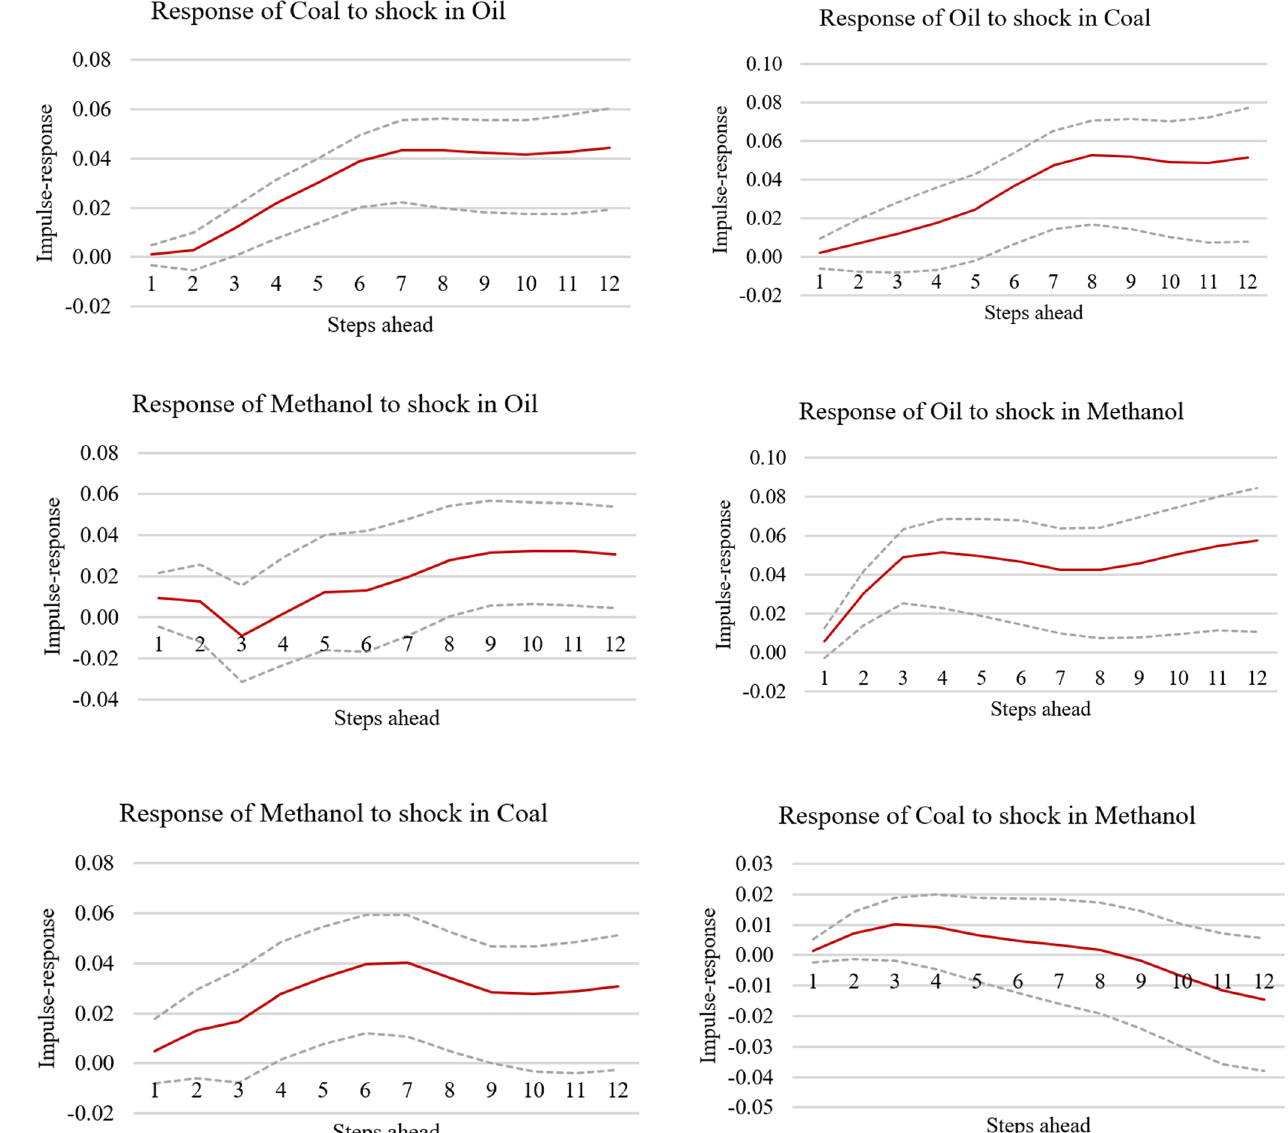
Figure 4. Generalized impulse-response functions. Dotted lines show 90% confidence bounds. When zero lies within the dashed lines (the 90% confidence interval), the response of the variable to a shock from another is considered statistically equal to zero and insignificant.